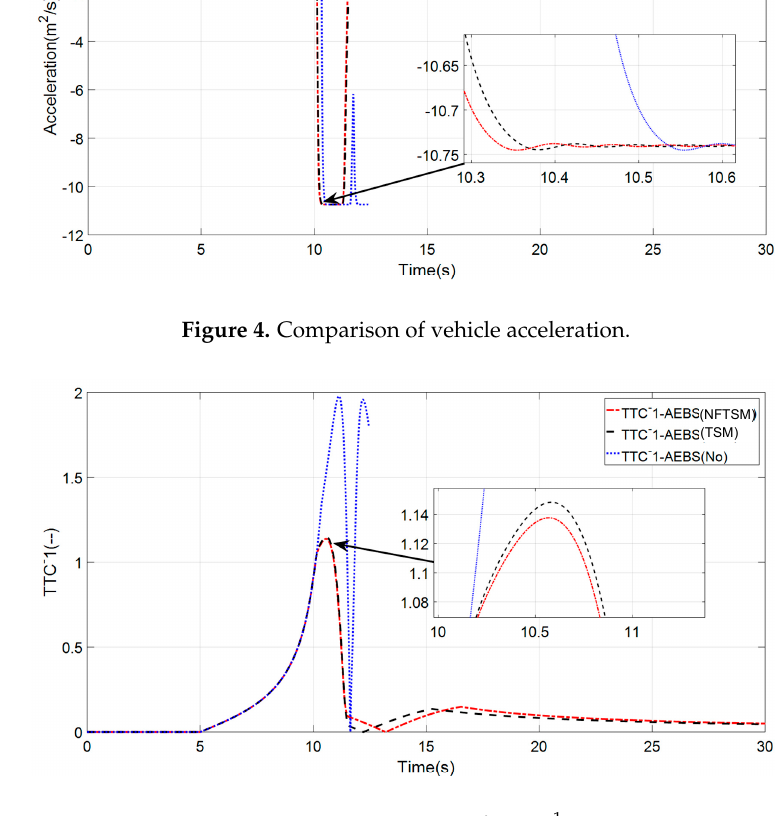
Figure 5. Comparison of TTC − 1 .